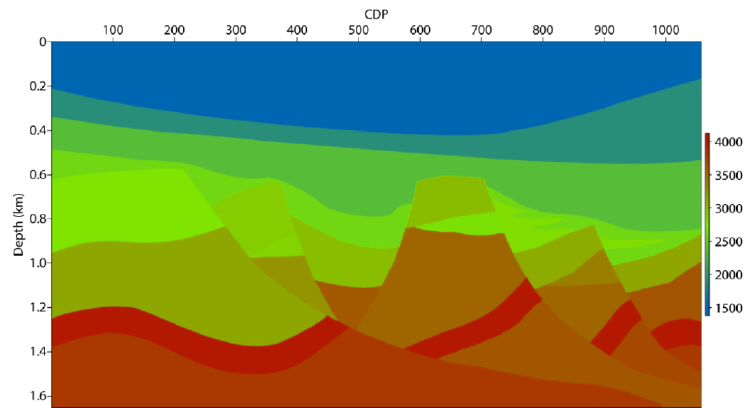
Figure 1. Imaging principle of the deabsorption prestack time migration (QPSTM). The shot point is the position where the seismic signal is generated and the geophone point is the position where the signal is received, and the image point is the underground position where the structure is studied. By calculating the travel time between the source-and-receiver pair, τ s and τ g can be obtained. Next, the compensation effect resulting from the Q factor along the wave-path in the frequency domain with an effective Q is determined to achieve the energy-compensated imaging result.